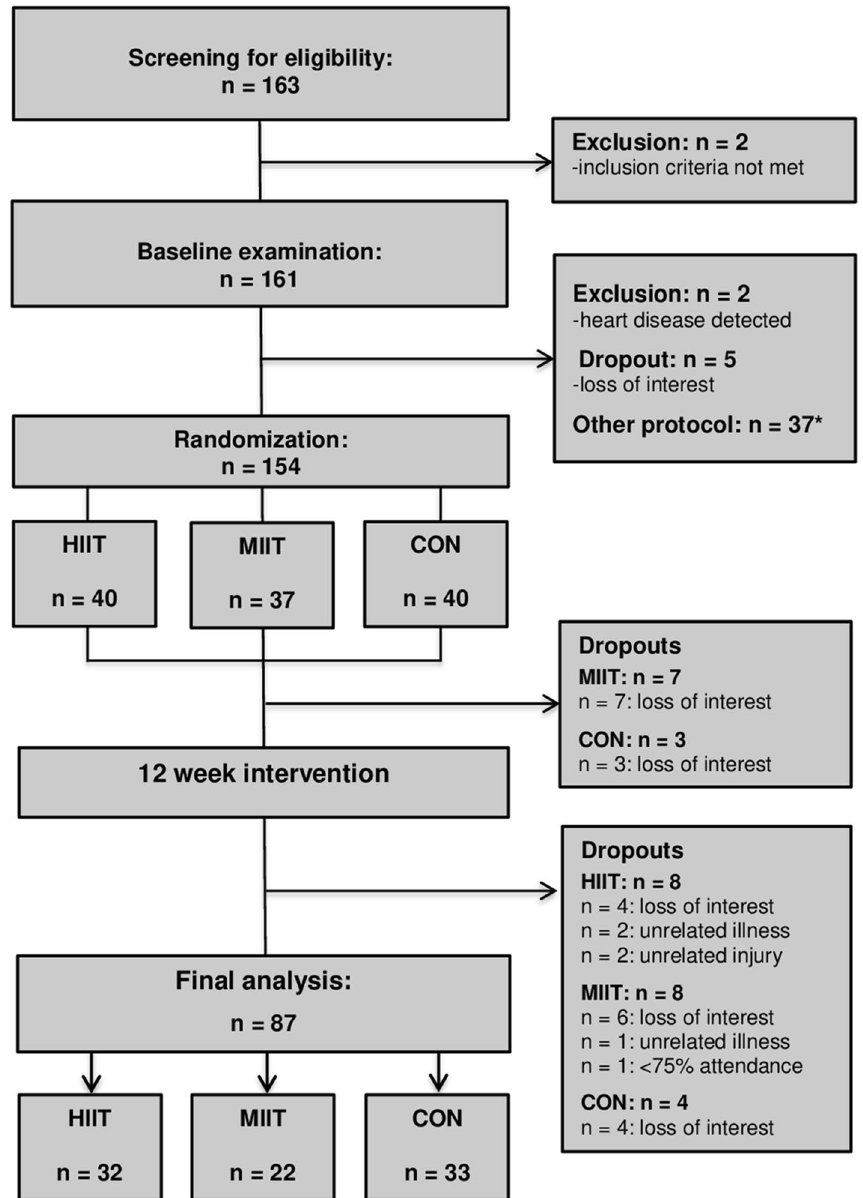
Figure 1. Study flow chart. HIIT, high-intensity interval training group; MIIT, moderate-intensity interval training group; CON, control group. *other exercise group (data not shown because not part of this specific study